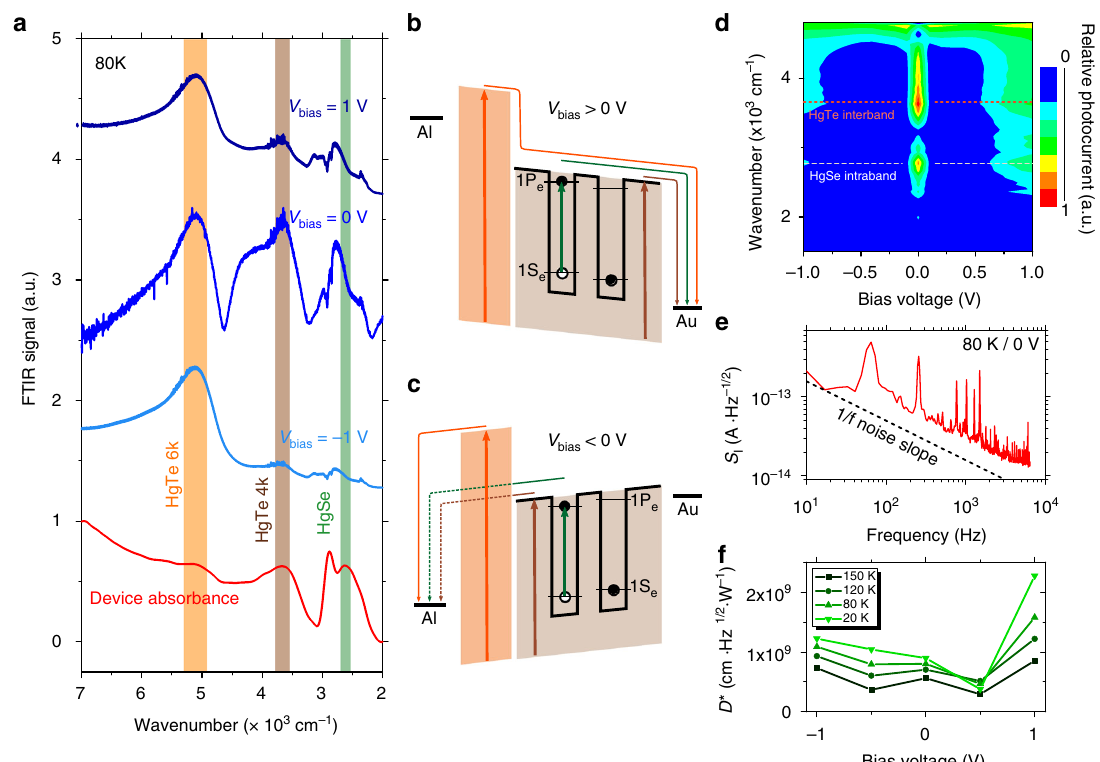
Fig. 5 Spectral characterization of the intraband photodiode. a Photocurrent spectra and device absorbance measured at 80 K for several diode biases. Spectral contributions (maximum of absorbance) of HgSe (green), HgTe 4k (brown), and HgTe 6k (orange) have been highlighted. b Scheme of the band structure under positive bias. c Scheme of the band structure under negative bias. d Photocurrent map showing the relative contribution of the colloidal quantum dot infrared photodetector layer to the total photocurrent as the bias is changed. Measurement is made at 80 K with a 100-mV resolution, and each spectrum is normalized to the contribution of HgTe 6k. e Current spectral density measurement at 80 K and in short-circuit condition, showing a typical 1/ f limited noise. f Speci fi c detectivity of the device measured at 1 kHz